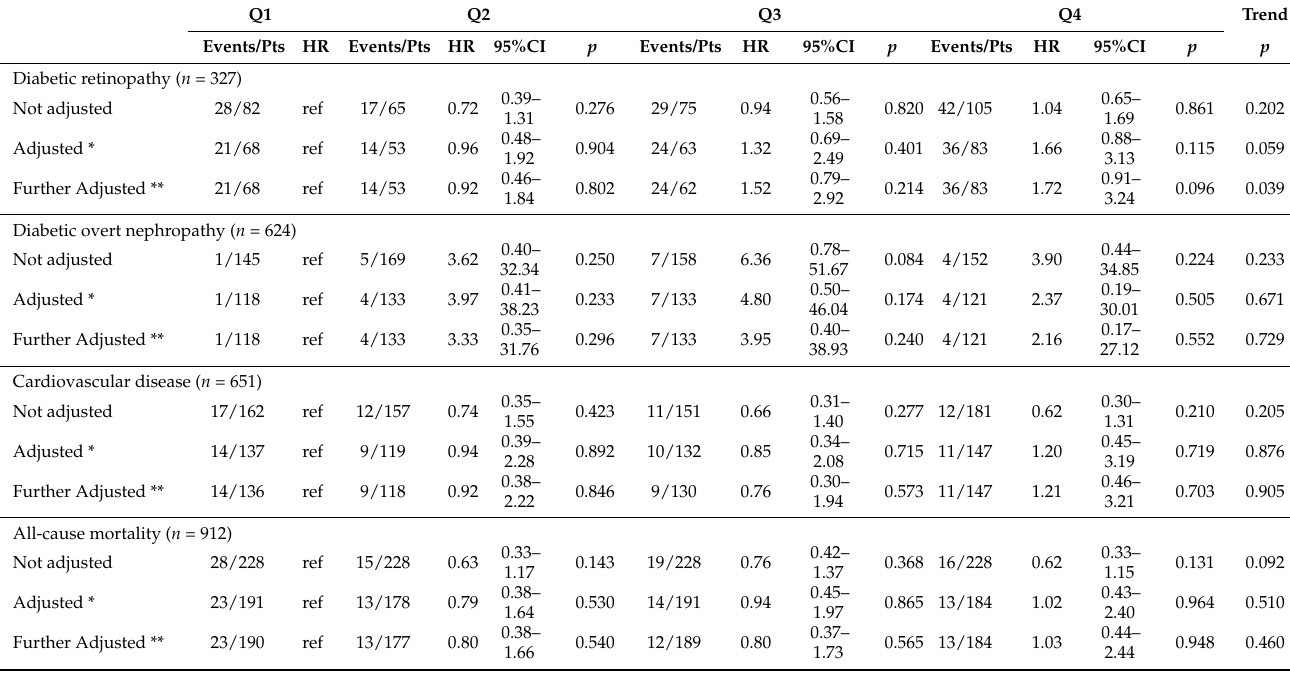
Table 3. Cox regression analysis of diabetes complications and all-cause mortality according to quartiles of sodium